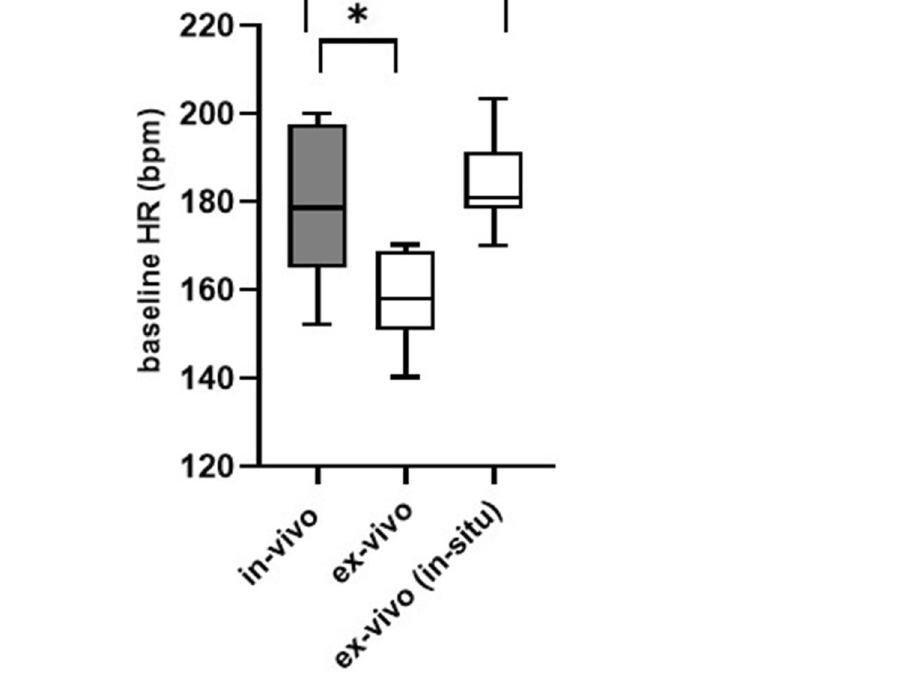
Figure 6. Comparison of the baseline heart rate in-vivo versus ex-vivo before and after heart explantation. Data are represented as mean and standard deviation (SD). The “*” symbol indicates statistical significance. Bpm: beats per minute. In-vivo: heart rate measurements after instrumentation in-vivo, in-situ: heart rate measurements prior to heart explantation in the ex-vivo animals, ex-vivo: after heart explantation in Langendorff mode, HR heart